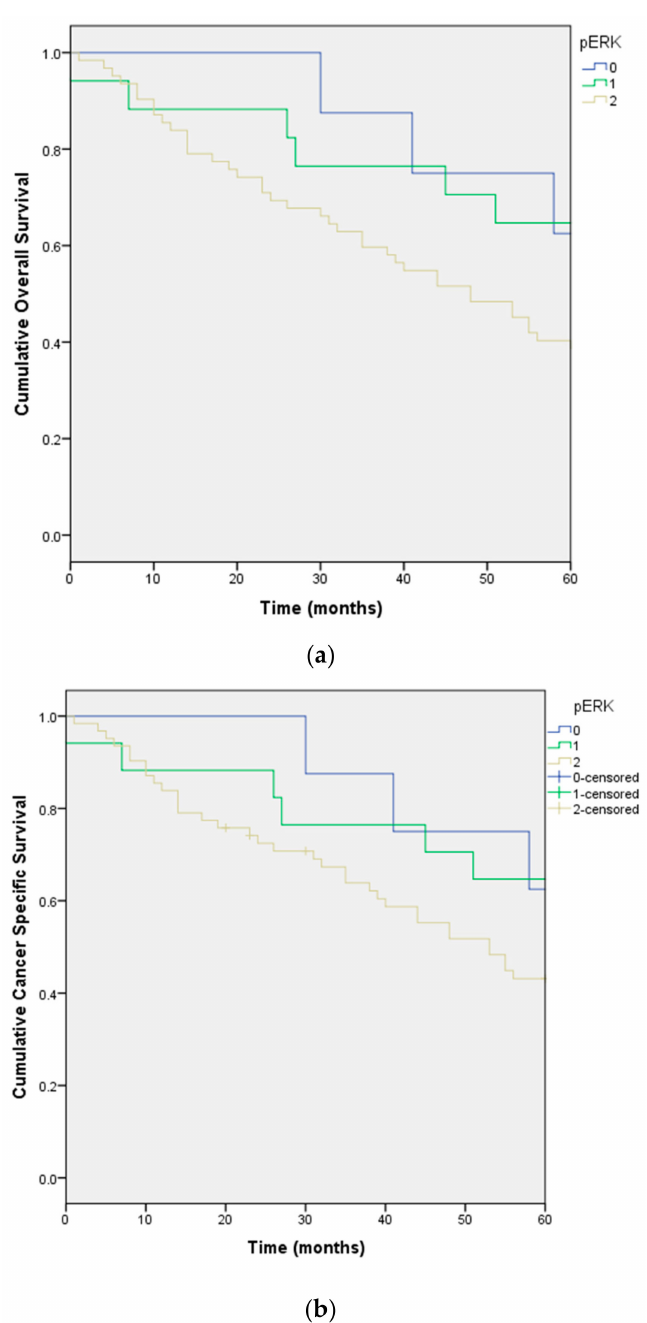
Figure 2. Overall survival ( a ); and cancer specific survival ( b ) stratified by differential expression of pERK in the cohort of 87 patients with soft tissue